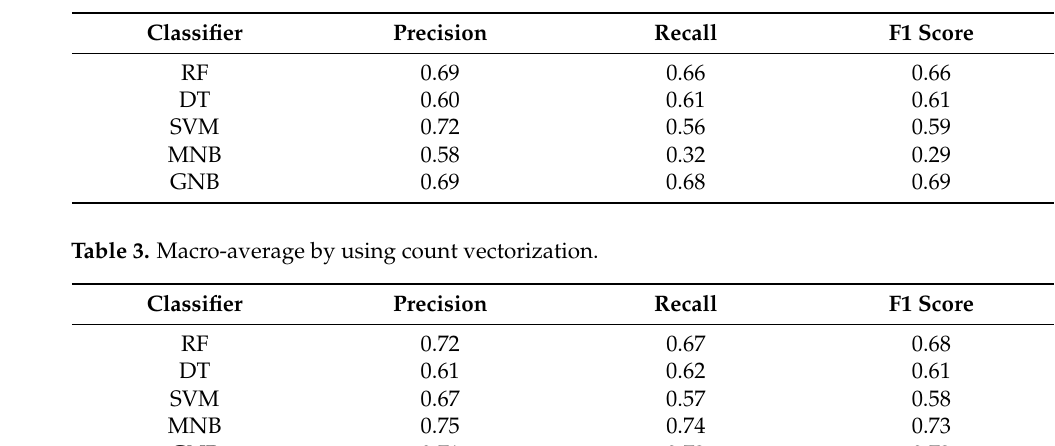
Table 2. Macro-average by using TFIDF vectorization.